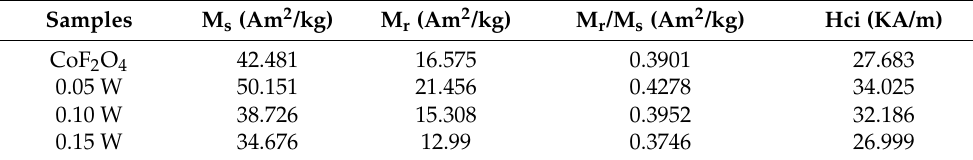
Figure 10. H-M hysteresis loops of CoW x Fe 2-2x O 4 samples.